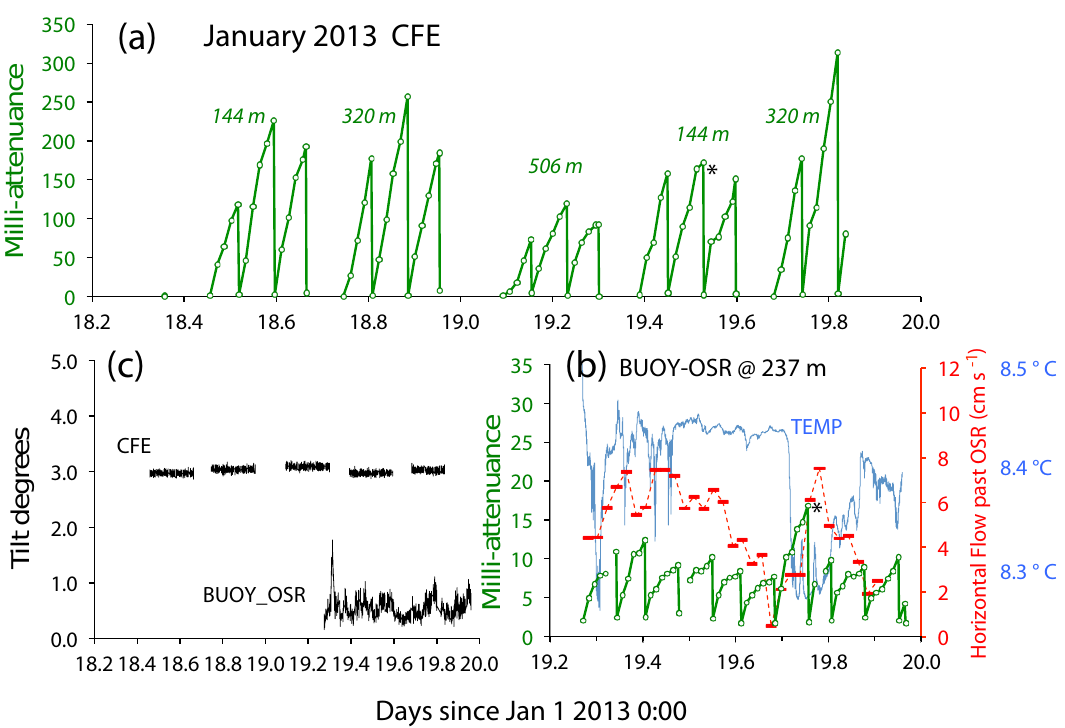
Figure 8. Time series of image attenuance from CFE and BUOY-OSR deployments in the Santa Cruz Basin during January 2013. Time axis shows days elapsed since 1 January at 00:00UTC. In (a) and (b) , the green lines depict the ATN time series. In (b) , red symbols depict currents relative to the BUOY-OSR at a depth of 237m that were calculated using ship broadband acoustic current profiler data (RDI Instruments, Ocean Surveyor 75) using methods of Hummon and Firing (2003) and 30min BUOY-OSR GPS positions. The current dropped briefly below 1cms − 1 and the rate of accumulation of particles in the BUOY-OSR increased. This moment was also the time when the first large aggregates were seen. Also shown in (b) in blue is the temperature time series from the logging CTD. The most obvious effect on particle collection rate by the BUOY-OSR was the relative lull in currents near day 19.68. Images from samples indicated by an asterisk are compared in Fig. 9. Panel (c) : time series of CFE and BUOY-OSR tilt in degrees. CFE tilt averaged 3 ◦ , whereas BUOY-OSR tilt averaged 0.5 ◦ .